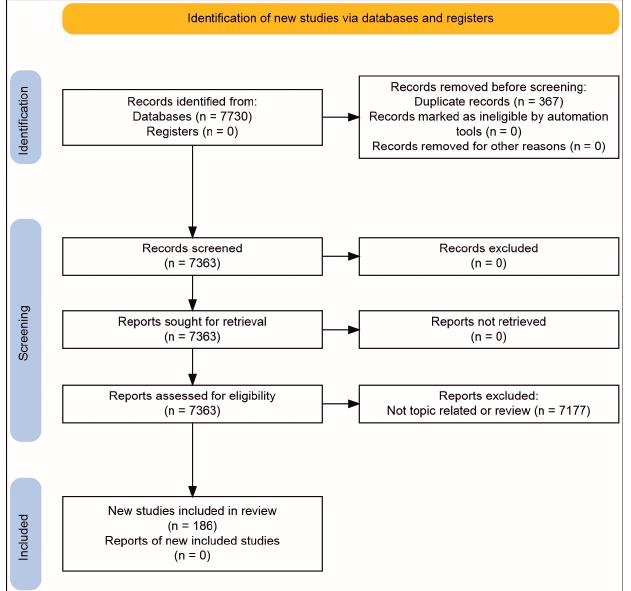
Figure 1. PRISMA fl ow diagram: literature search results for this concise review (made with h tt ps://estech.shinyapps.io/prisma_ fl owdiagram/), accessed on 9 March 2023. Figure 1. PRISMA flow diagram: literature search results for this concise review (made with https://estech. shinyapps.io/prisma_flowdiagram/), accessed on 9 March